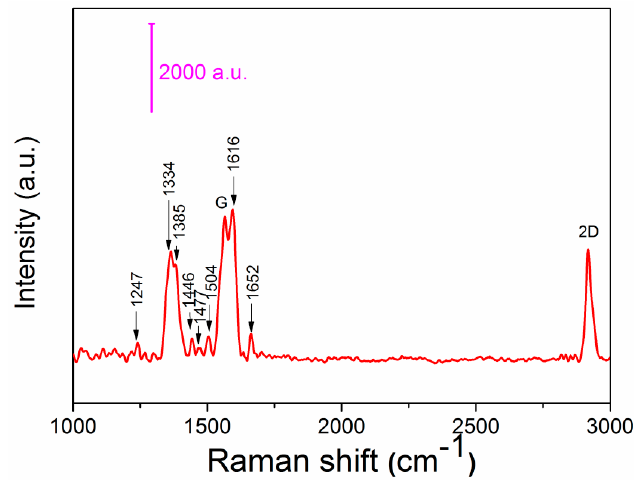
Figure 7. The D-region Raman spectrum of the fabricated biosensor.